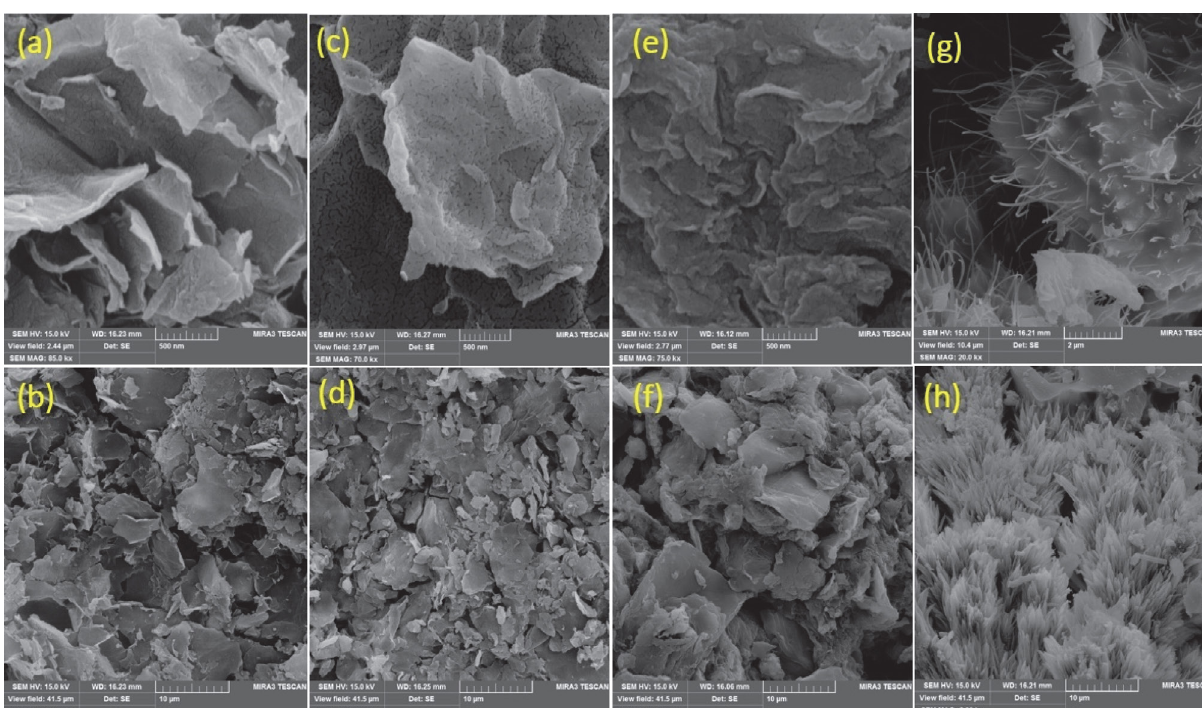
Figure 1. SEM images of (a,b) pristine GO/PAMAM, (c,d) GO/PAMAM modified at pH = 0 and ARS-adsorbed GO/PAMAM samples at (e,f) pH = 2 and (g,h) pH = 13. a)